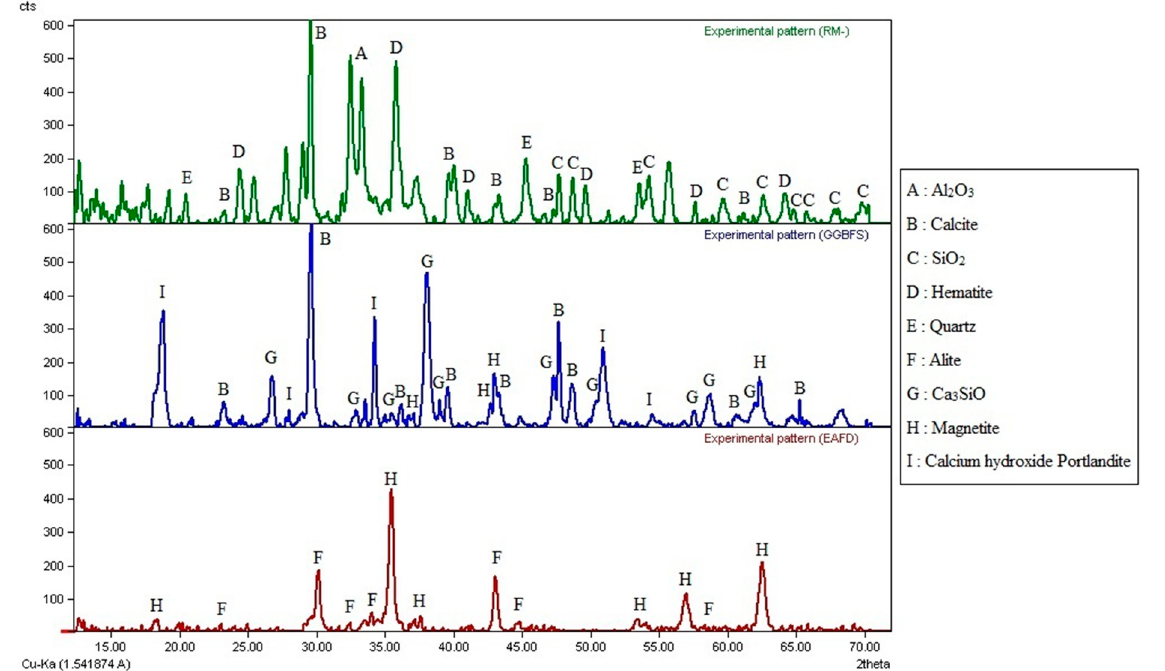
Figure 1. XRD pattern of RM, GGBFS, and EAFD (from top to bottom).